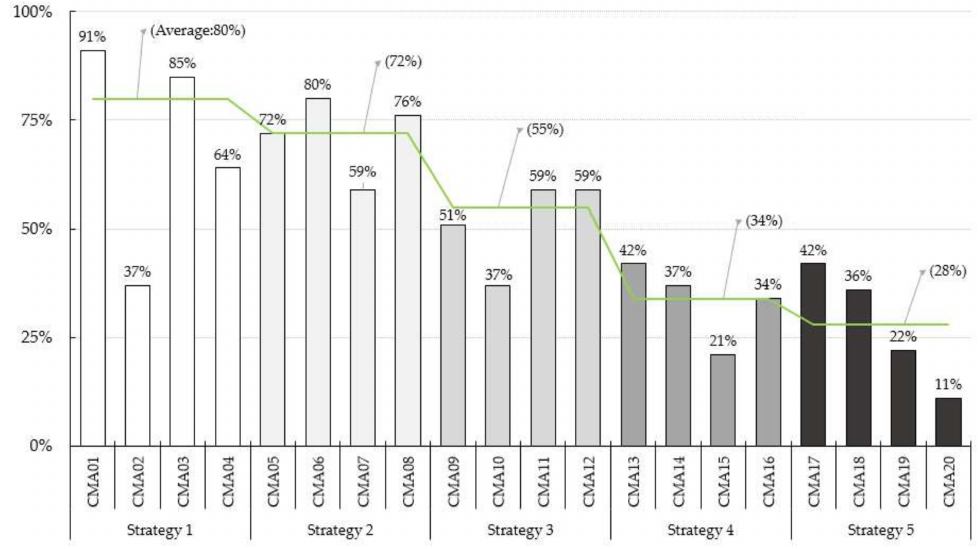
Figure 3. Statistic result of surveyed companies’ CMAs ( n =